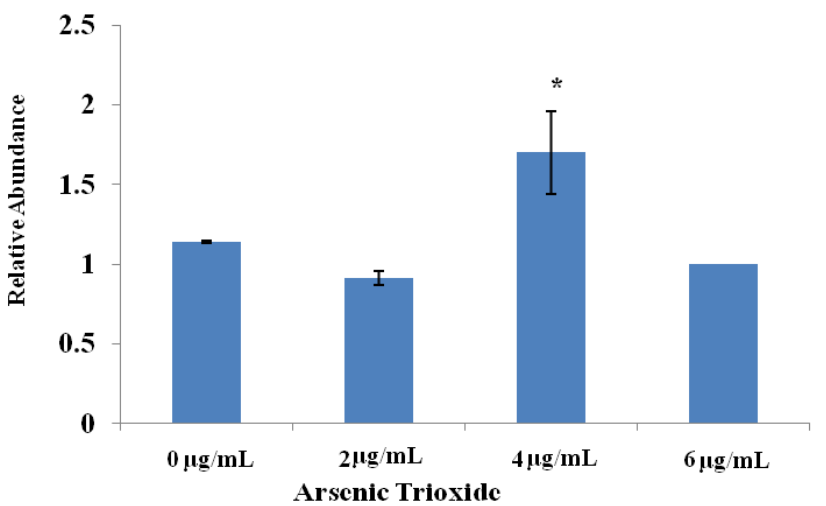
Figure 3b. Densiometric analysis of p38 MAPK expression in A549 cells exposed to arsenic trioxide. Data represent the mean values of three individual experiments done in triplicates. The intensities of the bands represented in Figure 3a were quantified and plotted as relative